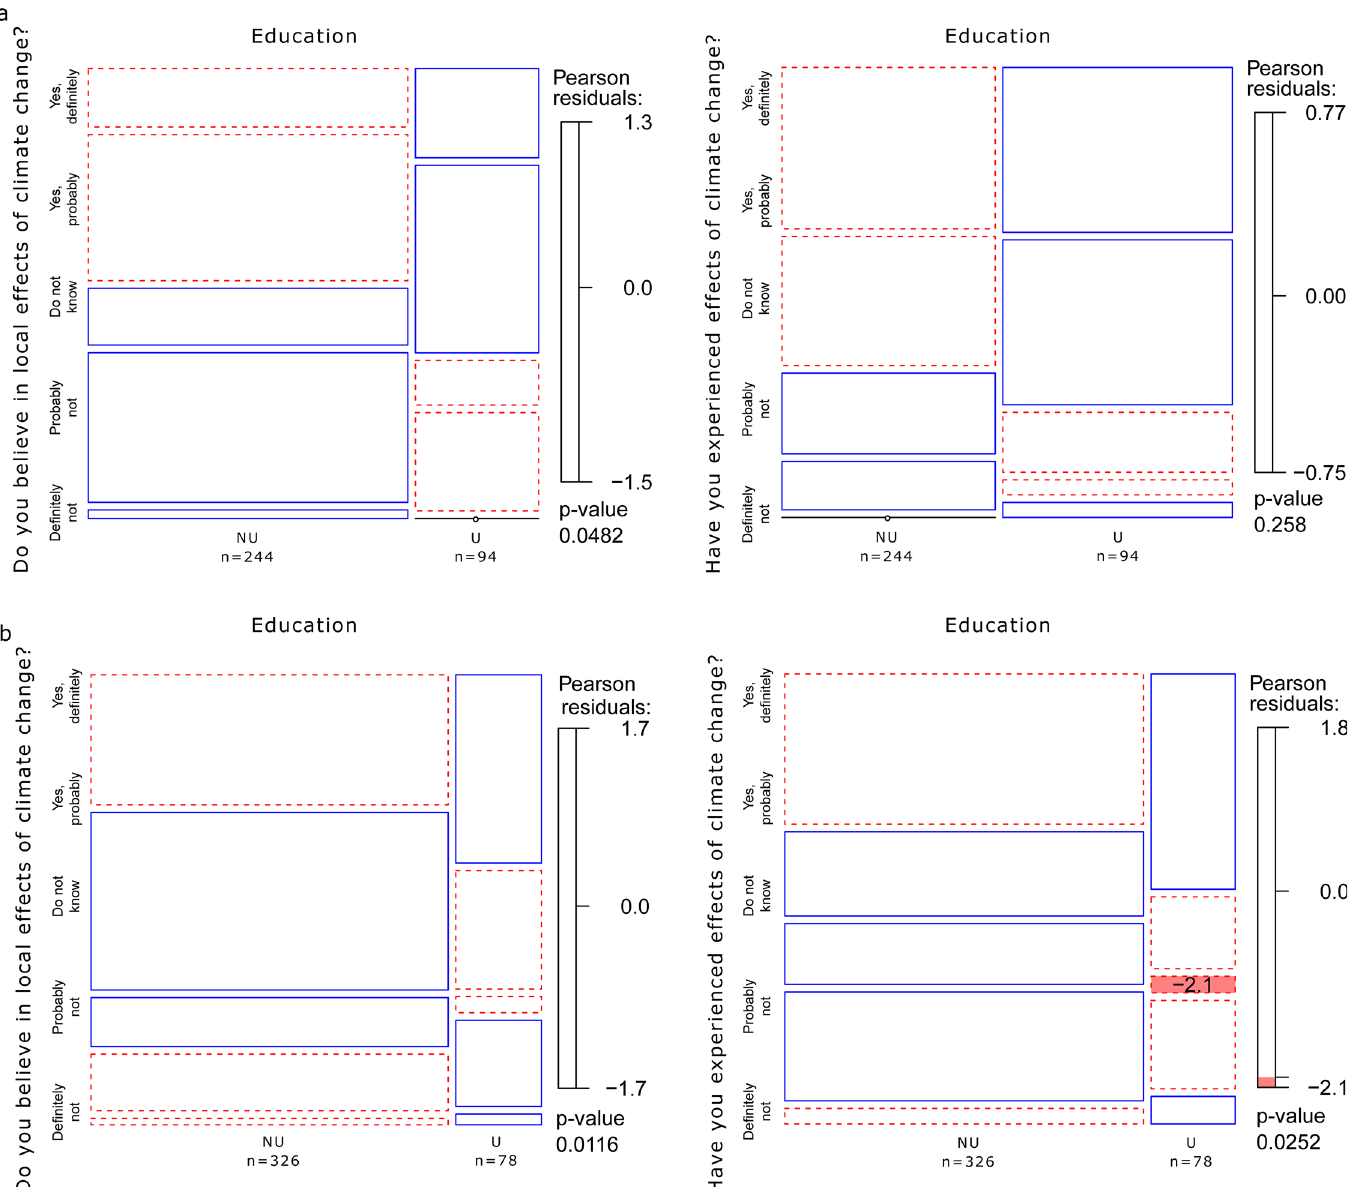
Fig 1. Relationship of climate change risk perception with university education. Relationships of risk perception in terms of the strength of belief in the local effects of climate change, the strength of belief in having experienced the effects of climate change and university education for Swedish (a) and German (b) respondents. The size of the respective compartment is proportional to the number of observations in the respective category. Pearson residuals outside of ± 2 correspond to a significant difference for individual cells at approximately α = 0.05. Positive Pearson residuals are delineated in blue and negative residuals in red. The graphs are based on raw data before imputation. NU – No university education; U – University